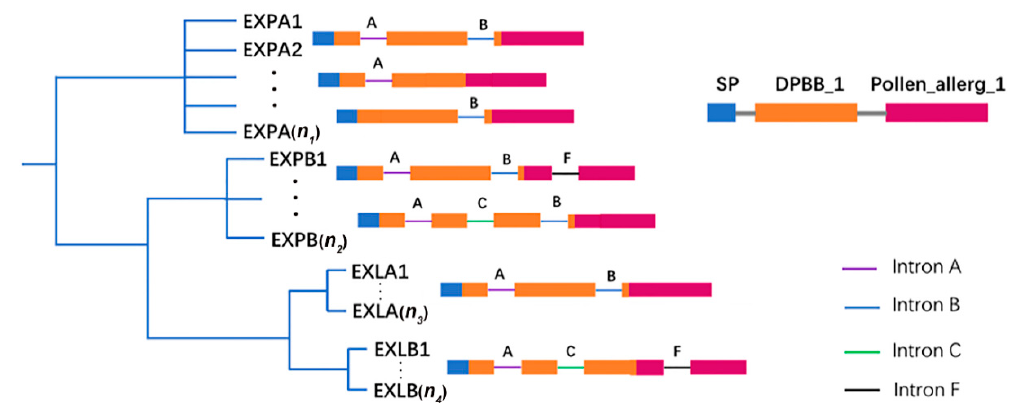
Figure 4. The gene structure and domain model of the four expansin subfamilies. Usually n 1 is the largest, followed by n 2 , n 3 , and n 4 . SP, signal peptide, DPBB_1 and Pollen_allerg_1 are two typical domains of expansins. Intron A, B, C and F were obtained from [5].